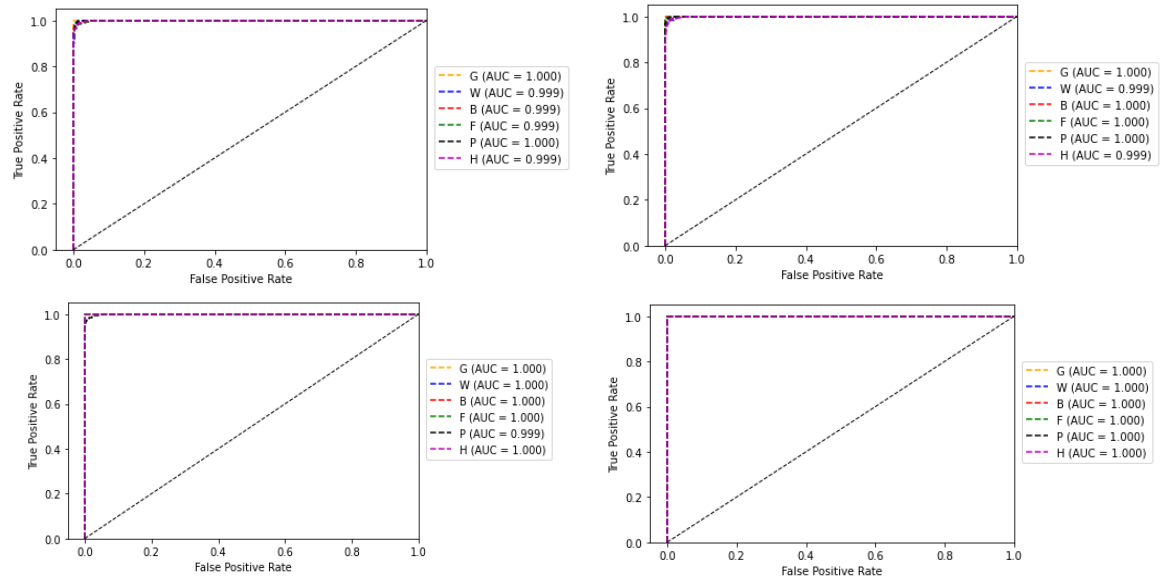
Figure 16. ROC curve and AUC values of base-learners with VGG16, Resnet34, MobilenetV2, and Ensemble models, respectively, for the reduced dataset.